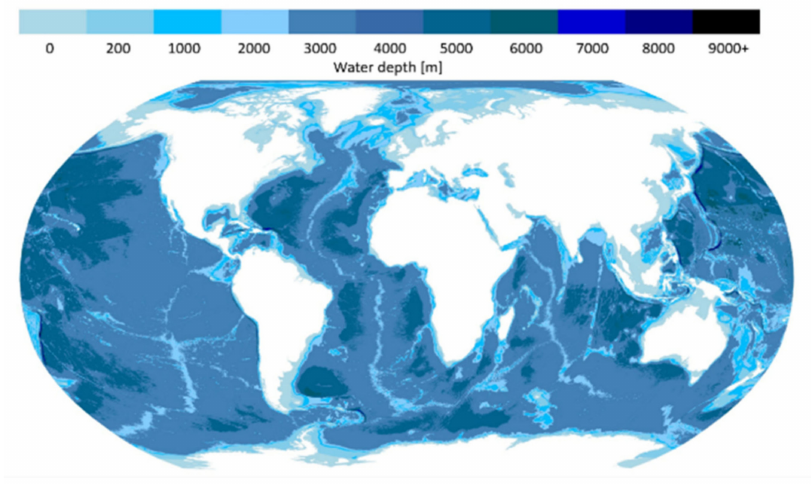
Figure 7. Map of worldwide water depth. Adapted from